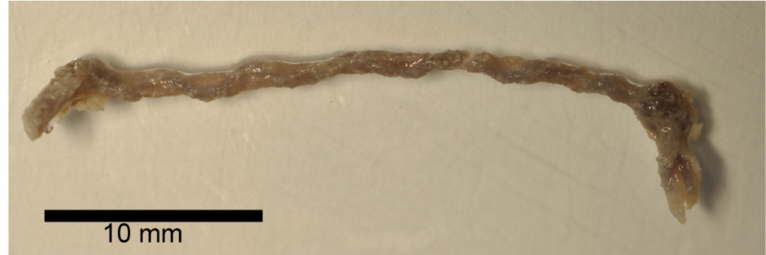
Figure 2. BraidStent-SF sample. The SF coating of the stent can be appreciated.